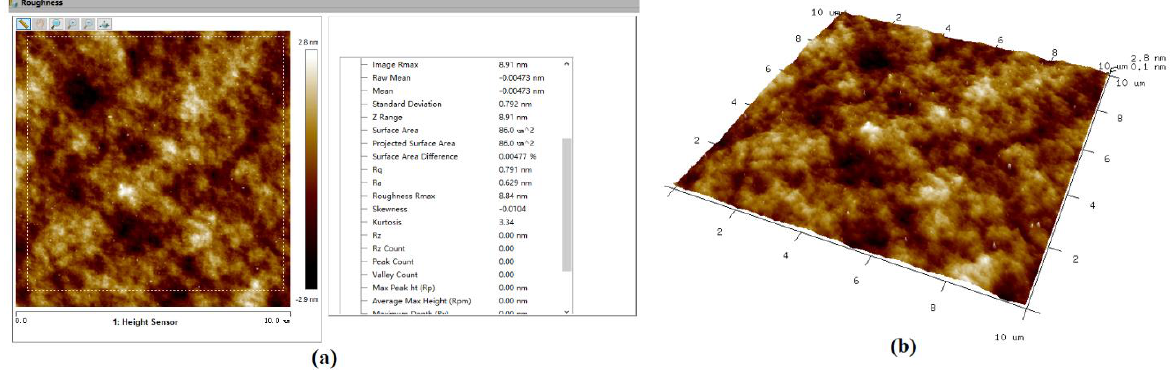
Figure 16. The Si workpiece surface after ultraviolet induced nanoparticle colloid jet machining. ( a ) Surface roughness and ( b ) surface morphology.